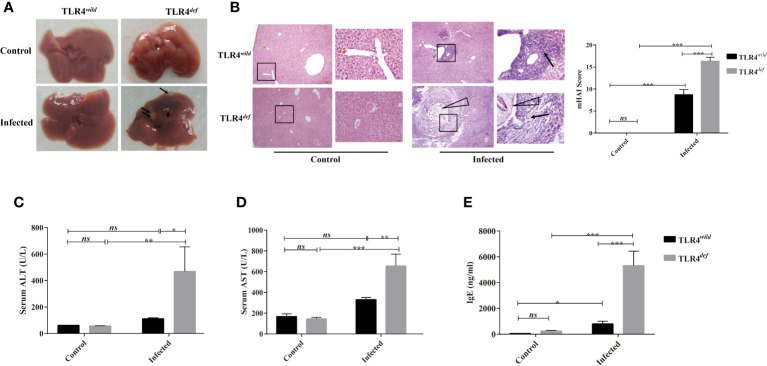
Toll-like receptor 4 (TLR4) deficiency aggravated liver injuries in C57BL/10 mice infected by Clonorchis sinensis. (A) Gross lesions in liver tissue of TLR4wild and TLR4def mice infected with C. sinensis. The arrow indicates the lesion nodule. (B) Histological changes of liver in TLR4wild and TLR4def mice infected with C. sinensis under 100× and 400× microscope were indicated by HE staining and liver histopathological changes were assessed by the mHAI score. An arrow indicates the infiltrated immune cells; triangle indicates worm bodies in the bile ducts. (C) The activities of alanine aminotransferase (ALT) and (D) aspartate aminotransferase (AST) were assessed in the sera of TLR4wild and TLR4def mice infected with C. sinensis. (E) The secretion of IgE in sera of TLR4wild and TLR4def mice infected with C. sinensis were determined using ELISA. The values were expressed as mean ± SEM. Compared with indicated groups, *P < 0.05, **P < 0.01, ***P < 0.001.